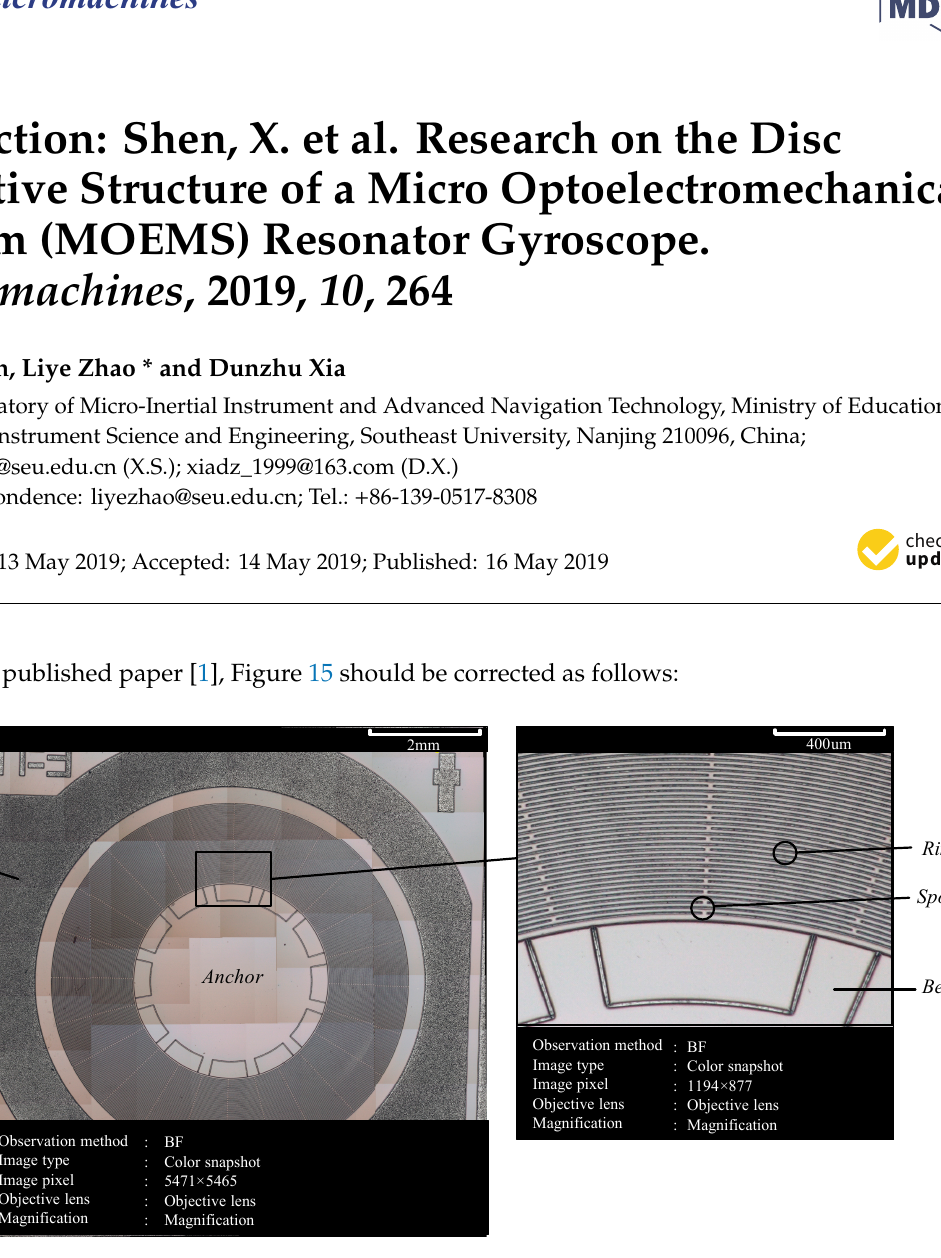
Figure 15. The photo of the fabricated micro optoelectromechanical system resonator gyroscope